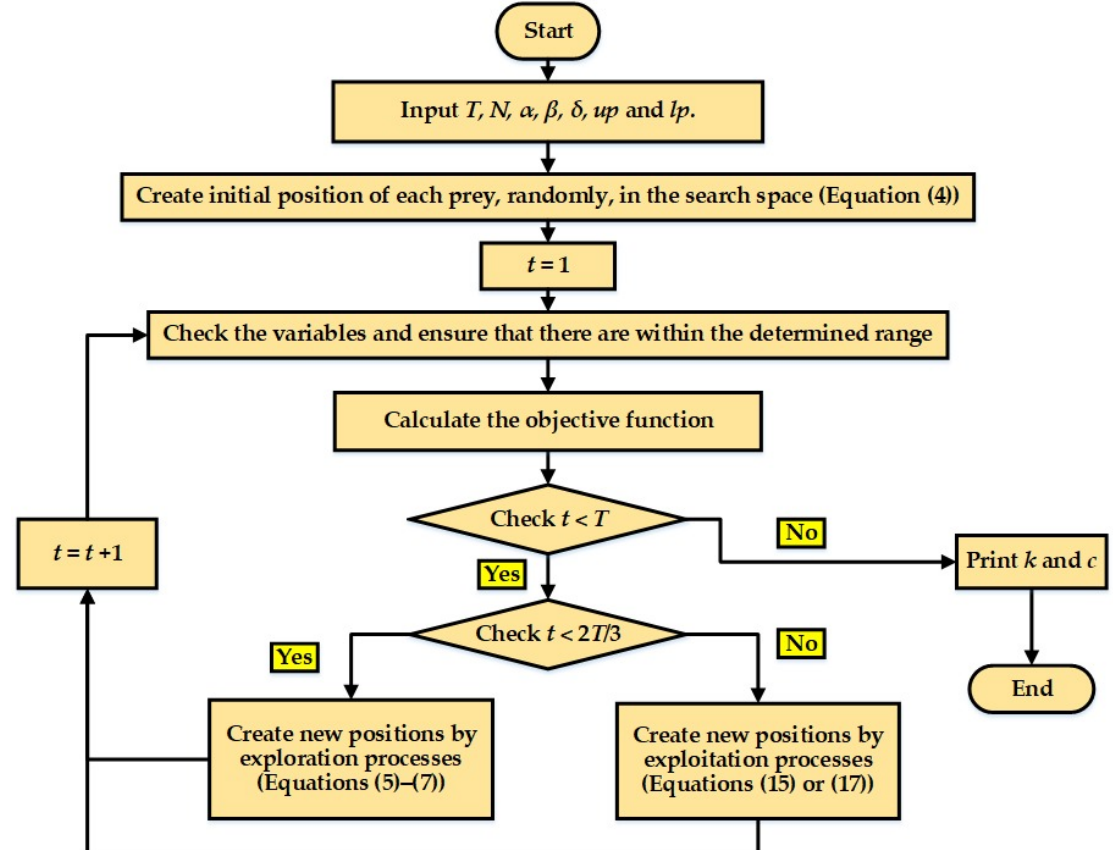
Figure 1. Flowchart of the AO for optimal estimation of Weibull parameters.